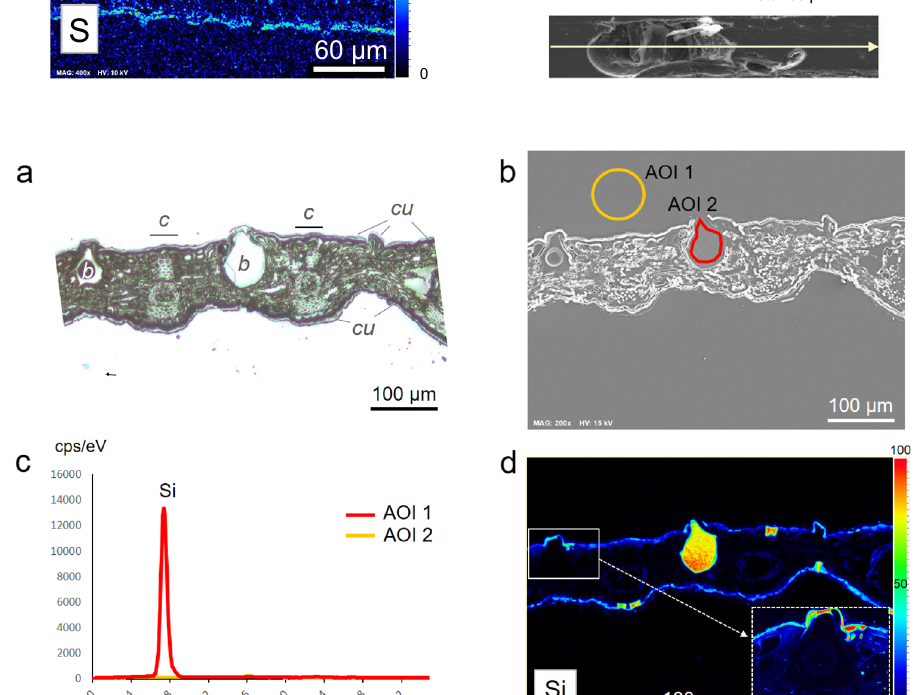
Fig. 2 Costal zone (vein) with dark inside content, also one bulliform cell (Primavera-16). a Light microscope picture with the dotted line demarcating margins of areas lost during sample leveling before SEM; b SEM image with demar- cated location of the EDS transect; c – e EDS maps Si, K and S, respectively; f Intensity of S along the EDS transect (below, magnification of the SEM corresponding to the EDS transect). Abbreviations: i = intercostal zone, c = costal zone, cd = costal zone with dark inside content, b = bul-